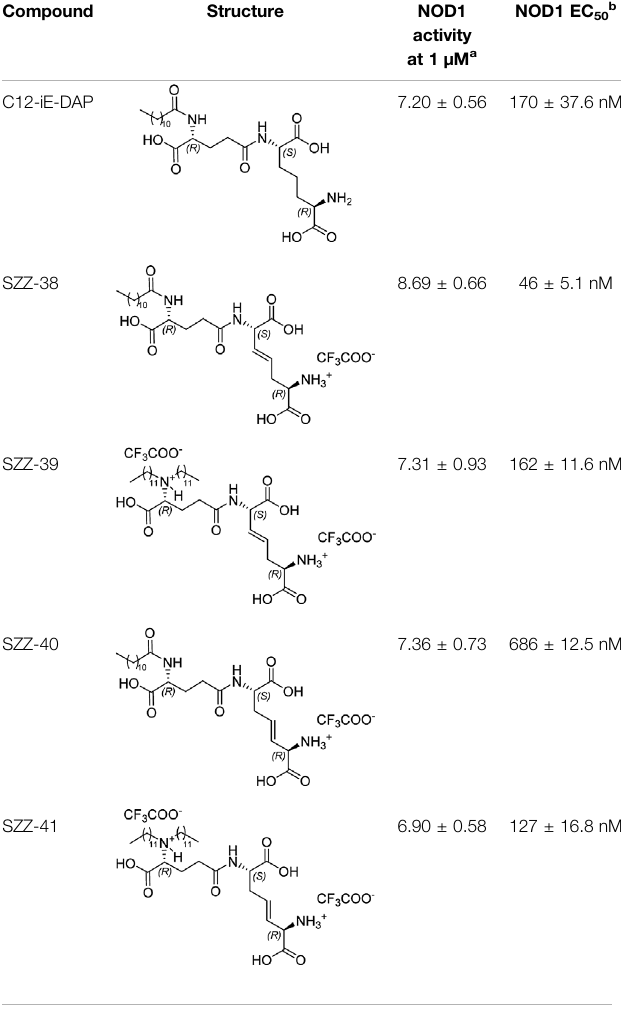
TABLE 1 | NOD1 agonistic activities of conformationally constrained iE-DAP derivatives.